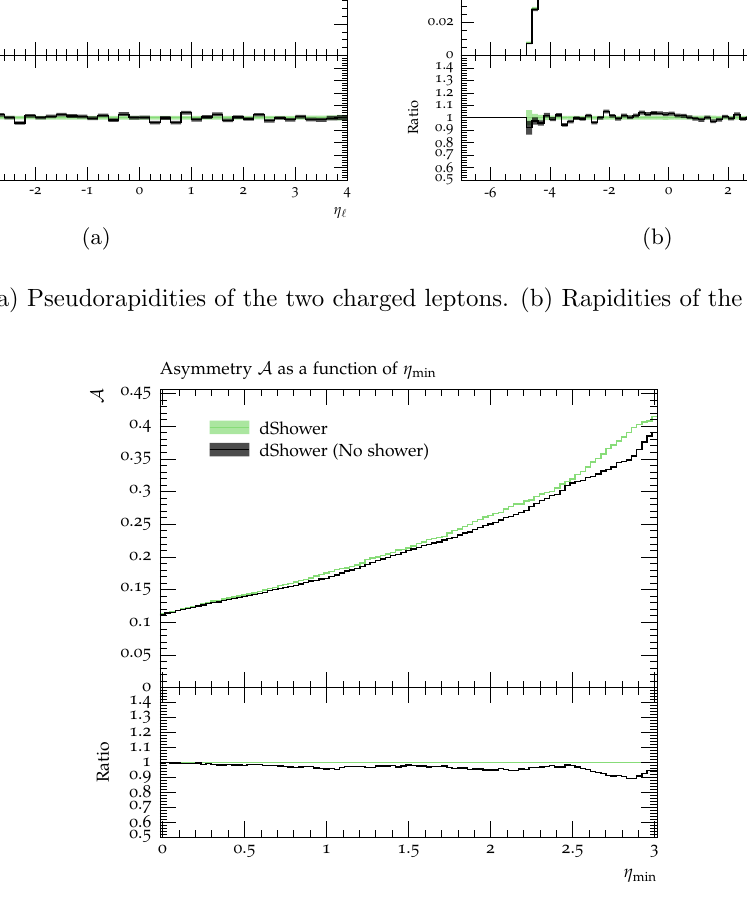
as a function of (cid:17) min A